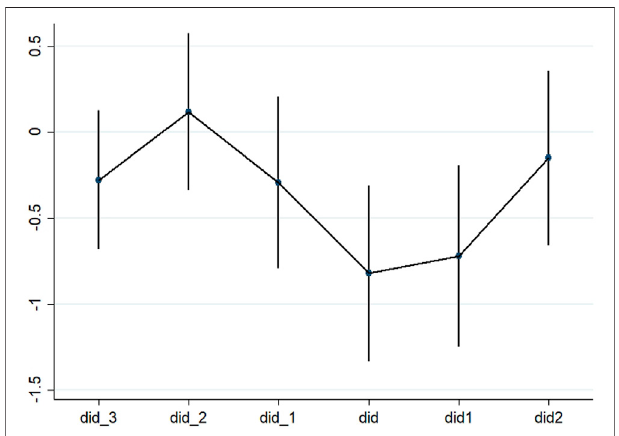
FIGURE 1 | Test for Assumption of parallel Trend.